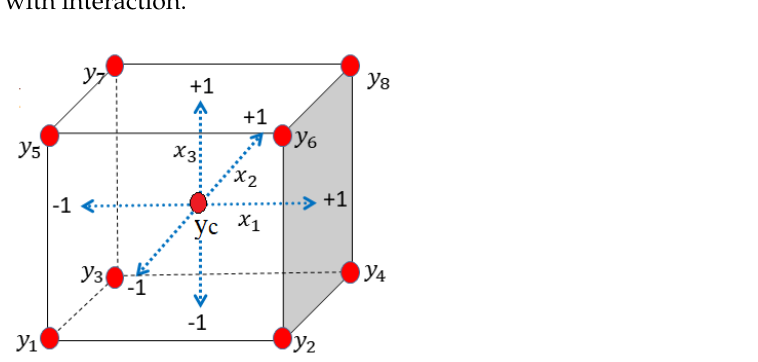
Figure 2. Two-level factorial design for three variables of temperature, humidity, and strain as X t , X h , and X ε , respectively. The red points (vertices of cube) are the measurement